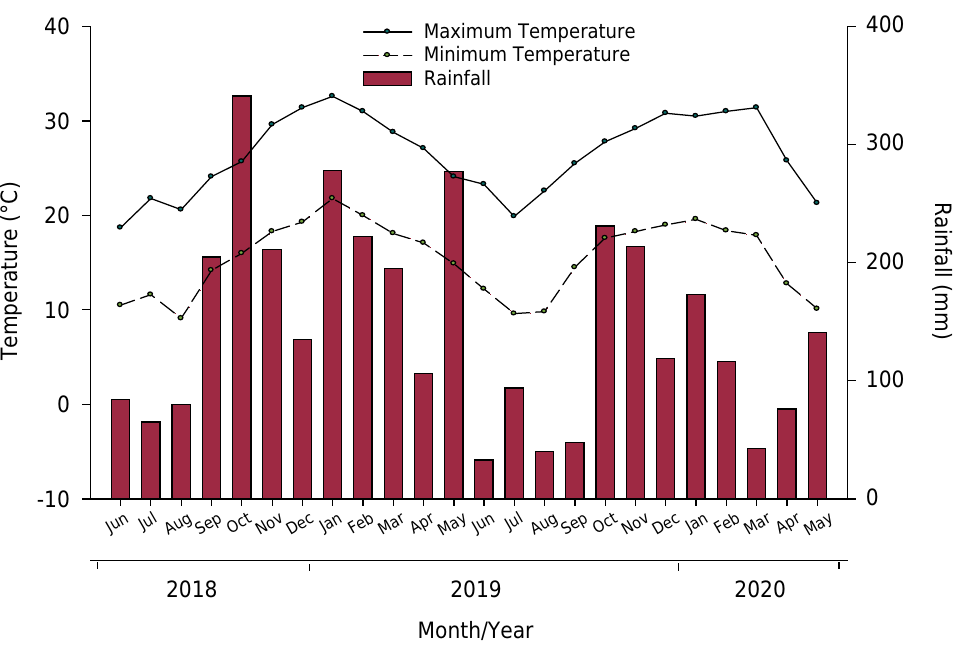
Figure 1. Precipitation (mm), maximum and minimum temperature (°C), registered during the experiment in the 2018-2020, crop seasons, Concórdia, Santa Catarina,